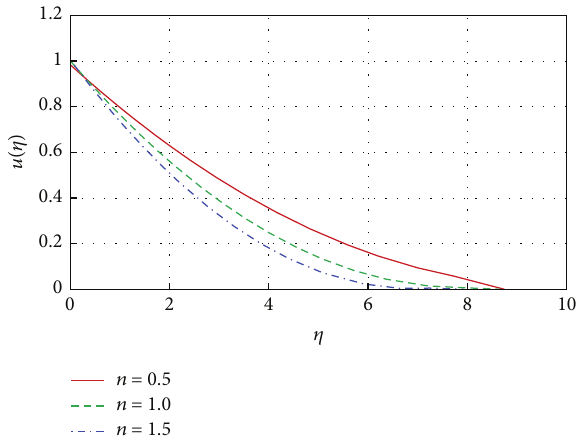
Figure 4: Vertical velocity of non-Newtonian fluid at the vicinity of stretching sheet for constant values of Pr = 5 .